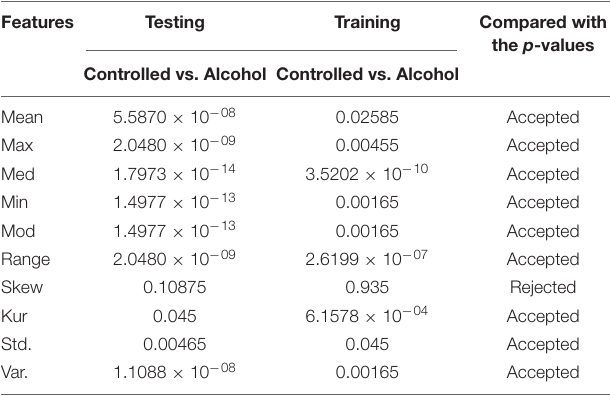
TABLE 2 | Feature set outcome of Experiment No. 2.